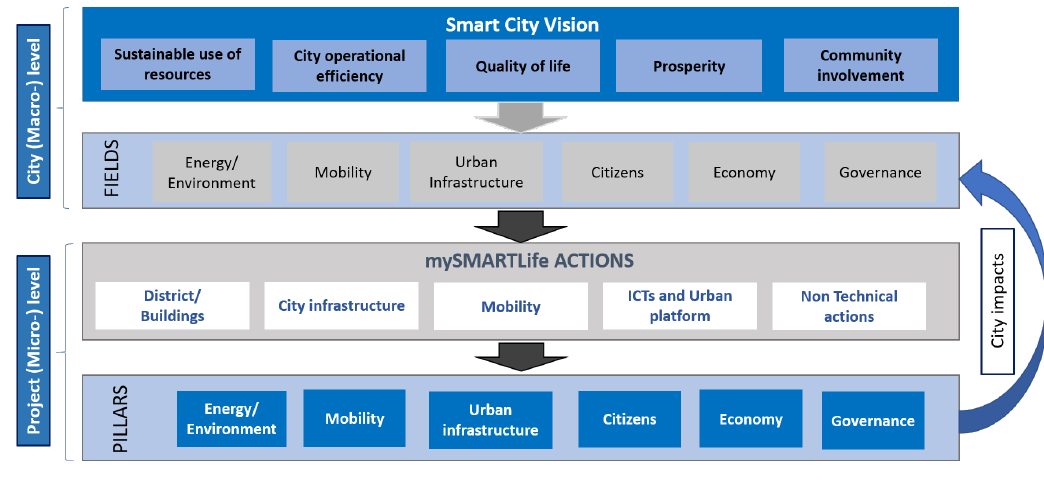
Figure 2. KPI-driven assessment framework.